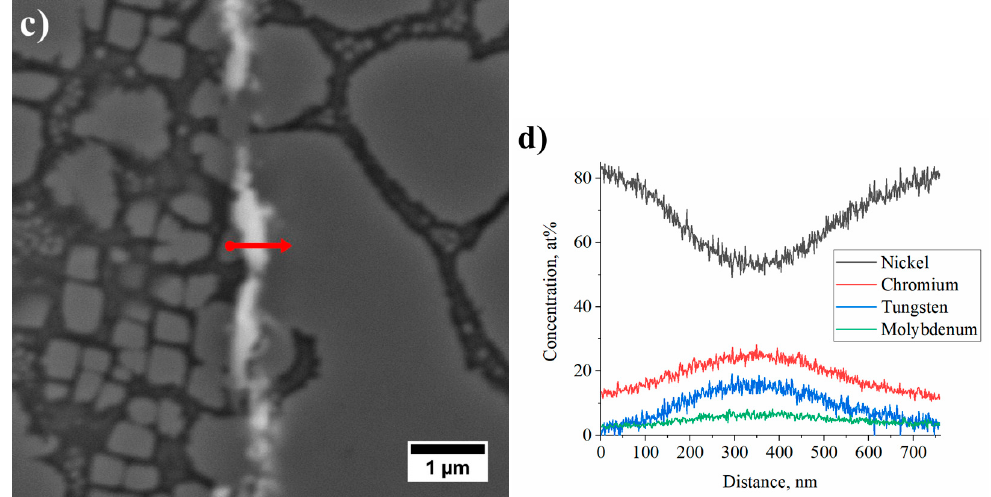
Figure 9. ( a,b ) microstructure of precipitates at the grain boundaries; ( c ) location of linear SEM-EDX analysis; ( d ) distribution of selected alloying elements at a grain boundary.